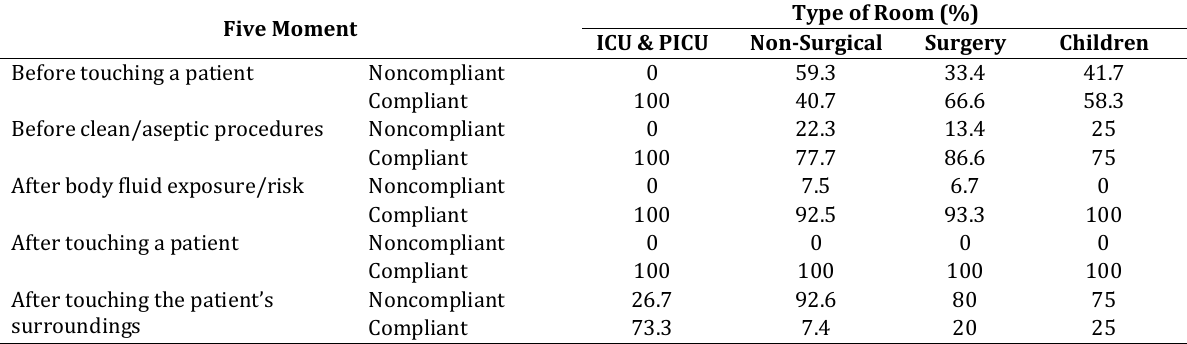
Table 5. Relationship of Nurses’ Individual Characteristics toward Handwashing Compliance Compliance with Characteristics of Individual Respondents